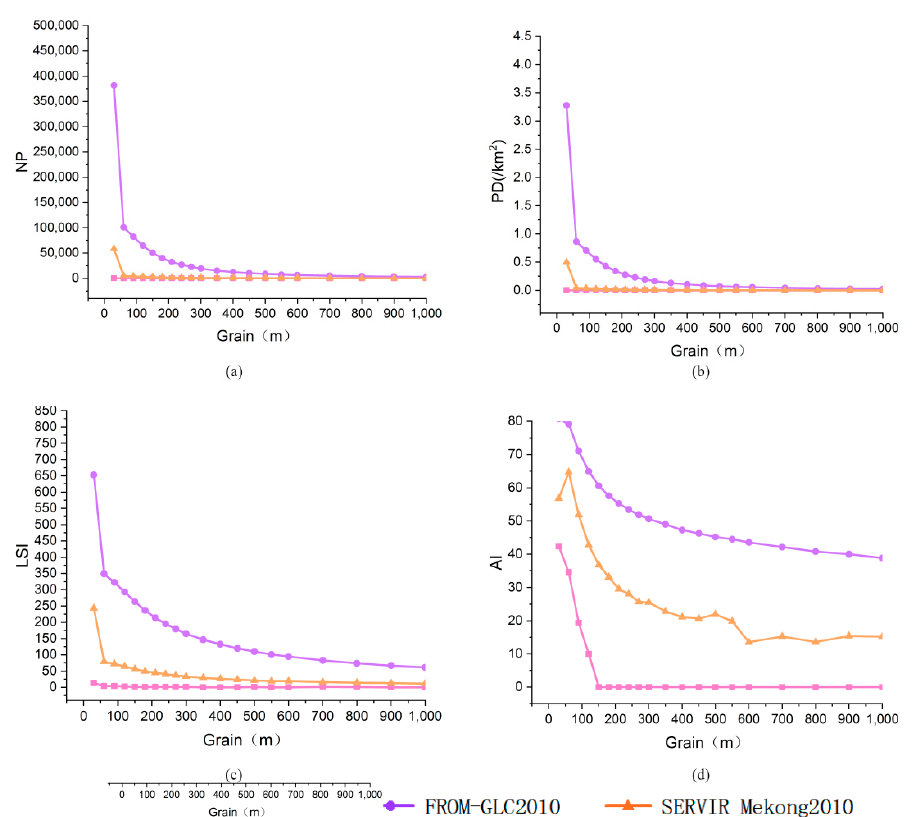
Figure 9. The bareland landscape pattern indices changing curves with scale increasing. ( a ) is the NP curve; ( b ) is the PD curve; ( c ) is the LSI curve; ( d ) is the AI curve.